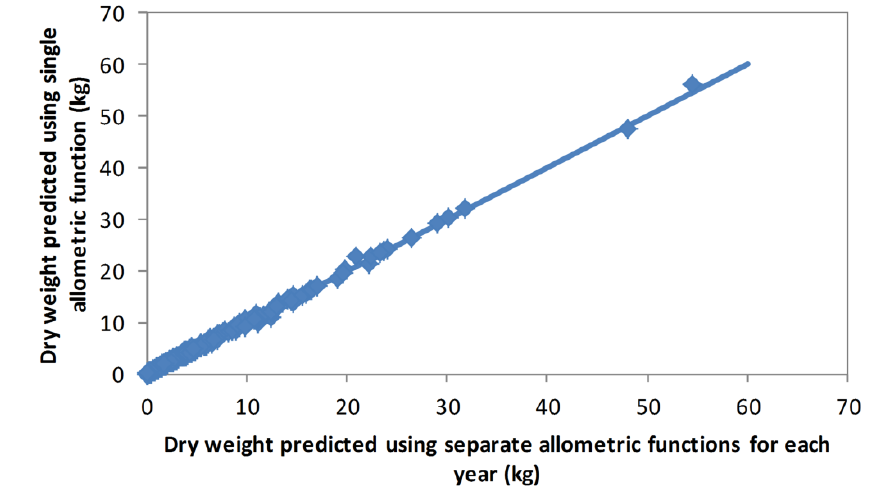
Figure 1. Oven dry weights of individual shrubs estimated using a single allometric function developed from the combined biomass data, and using allometric functions developed separately for the 2008 and 2012 biomass data.